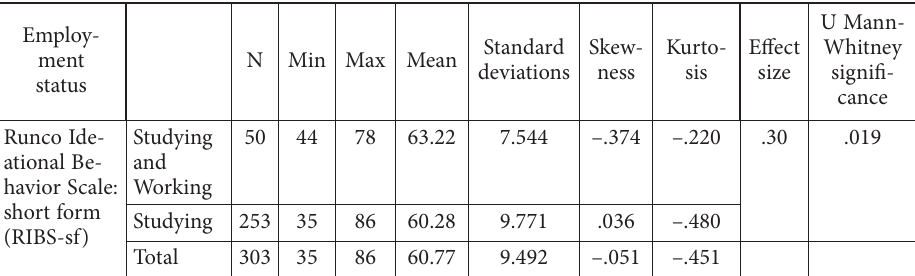
Living at/away from home